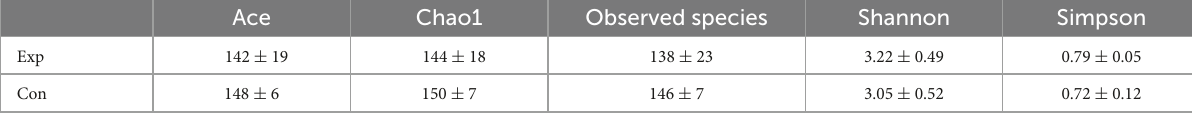
TABLE 4 Effect of chlorogenic acid on alpha diversity index of intestinal